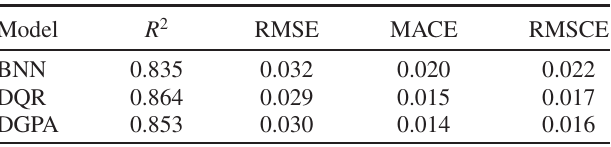
TABLE II. In-distribution prediction performance for BNN, DQR, and DGPA models.